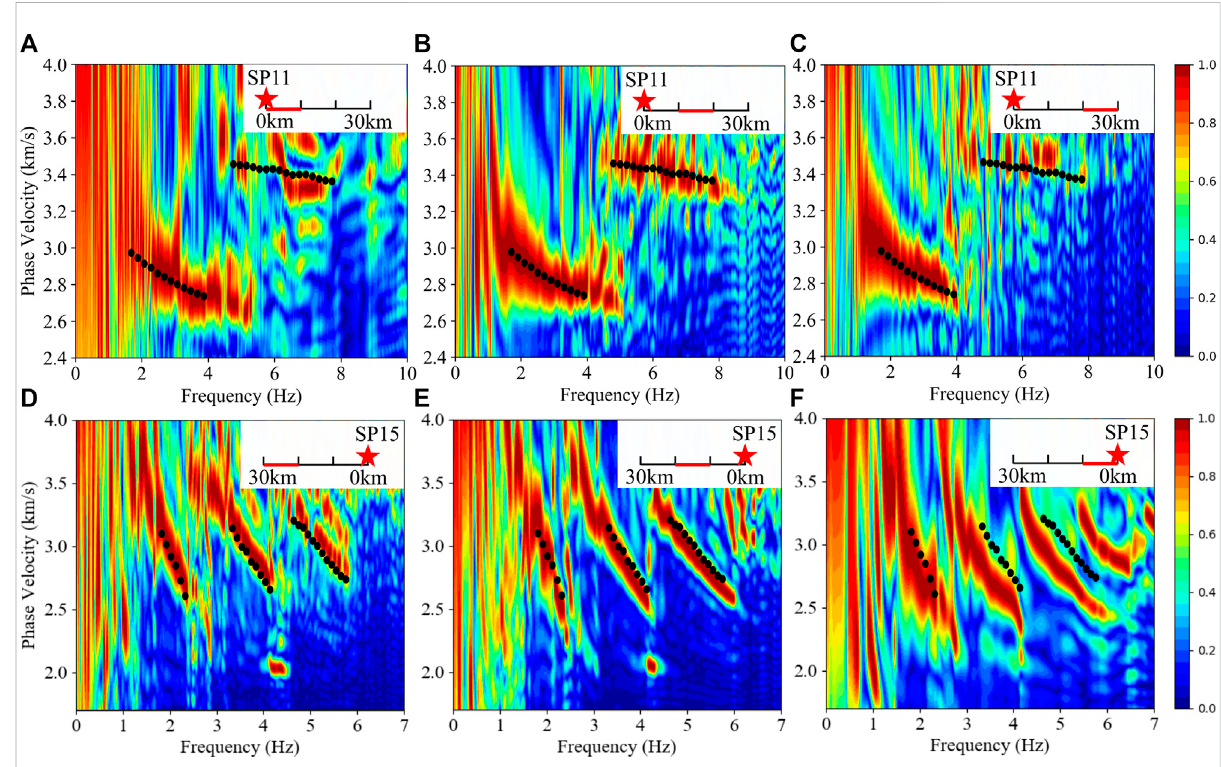
FIGURE 5 F – J spectrograms extracted from the 10-km-long seismic record sections. In the upper right corner of each fi gure, the stars represent the sources, and the F-J spectrograms are extracted from seismic data on the red lines. The black dots in (a) – (c) are the dispersion curves picked from the 30-km-long SP11 F-J spectrograms (Figure 4A), and the black dots in (D – F) are the dispersion curves picked from the 30-km-long SP15 F-J spectrograms (Figure 4B). (A – C) are the F-J spectrograms extracted from the 0 – 10 km offset, 10 – 20 km offset, and 20 – 30 km offset of SP11, respectively. (D – F) are the F-J spectrograms extracted from the 20 – 30 km offset, 10 – 20 km offset, and 0 – 10 km offset of SP15,